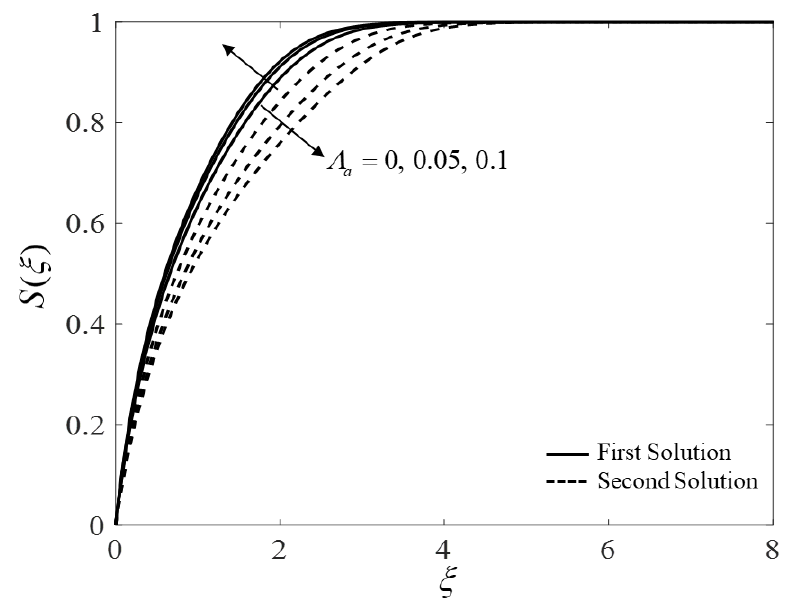
Figure 11. Concentration distribution S ( ξ ) for different values of Λ